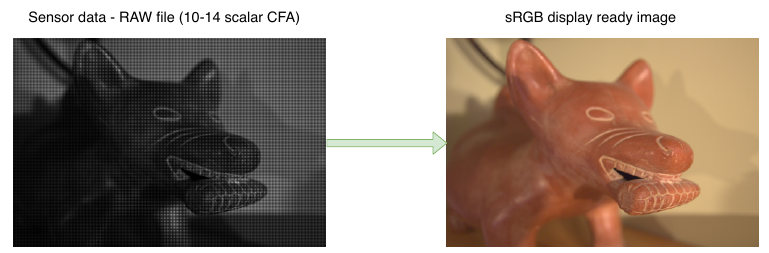
Figure 2. Problem of processing raw image